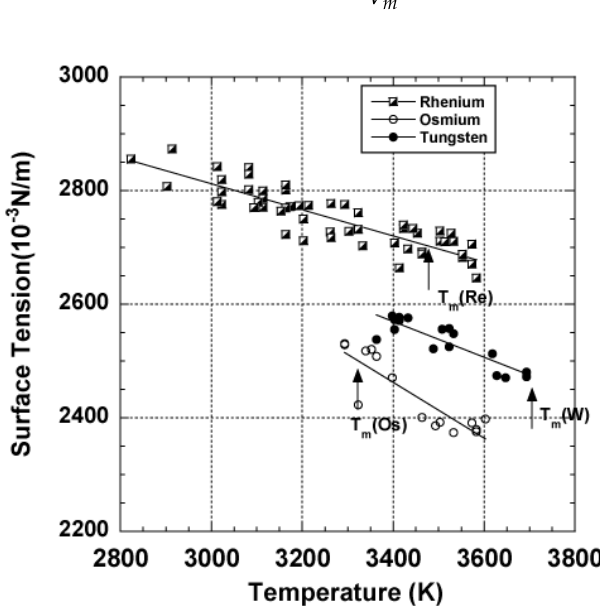
Figure 10. Surface tension of W, Re, and Os versus temperature.